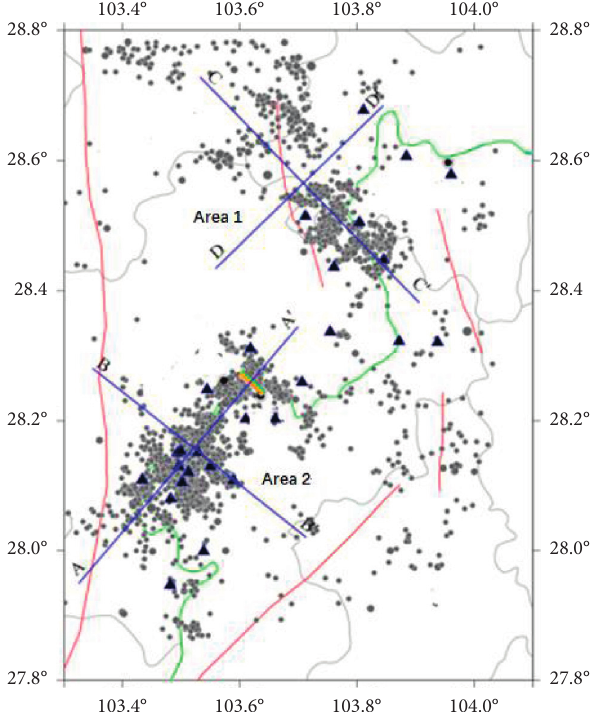
Figure 1: Spatial distribution of small earthquakes in the reservoir